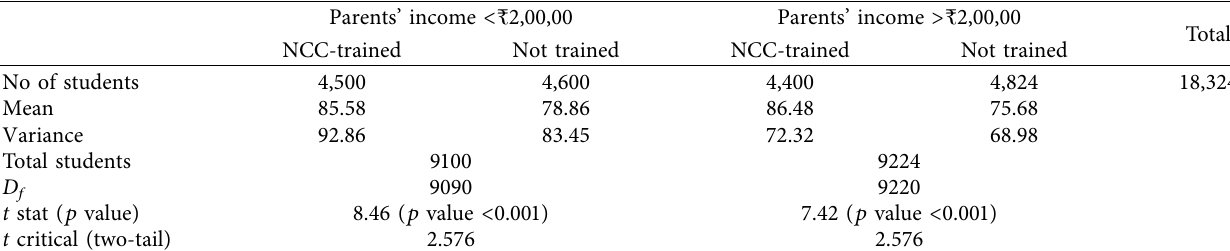
Table 8: Results of personality development qualities among students’ parents income level in Madras group.